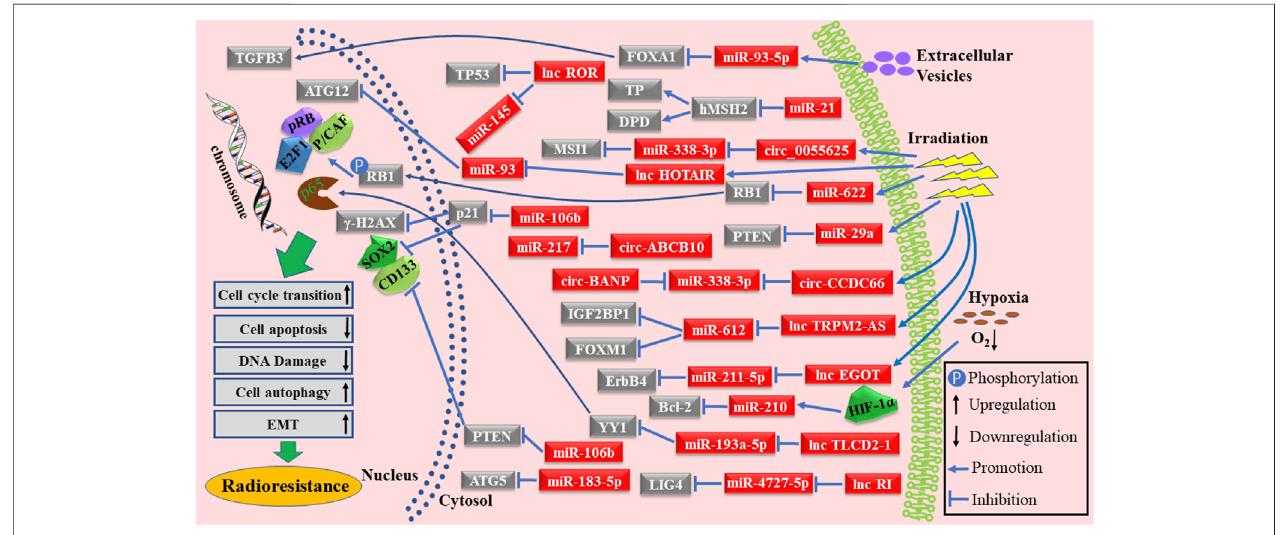
FIGURE 2 | Schematic diagram of ncRNAs as radioresistance inducers in gastrointestinal carcinoma.